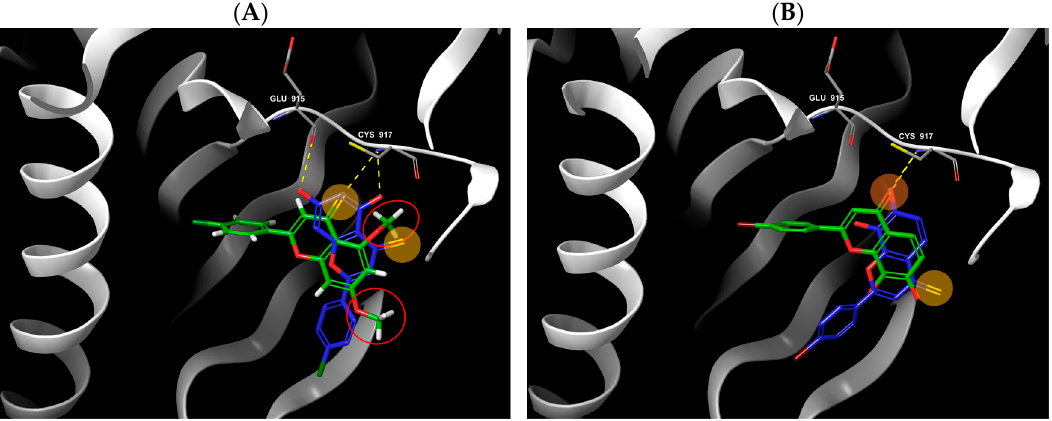
Figure 10. Cartoon representation showing the different orientations (horizontal or vertical) of flavonoid derivatives ( 4b , 5a , b and 6a ) in ATP-binding pocket of VEGFR2 resulting from the high- lighted structural differences (yellow shadow, C=S; red circle, OCH 3 ; red shadow, C=O). ( A ) 4b (green, horizontal orientation) vs. 5b (blue, vertical orientation); ( B ) 5a (blue, vertical orientation) vs. 6a (green, horizontal orientation).